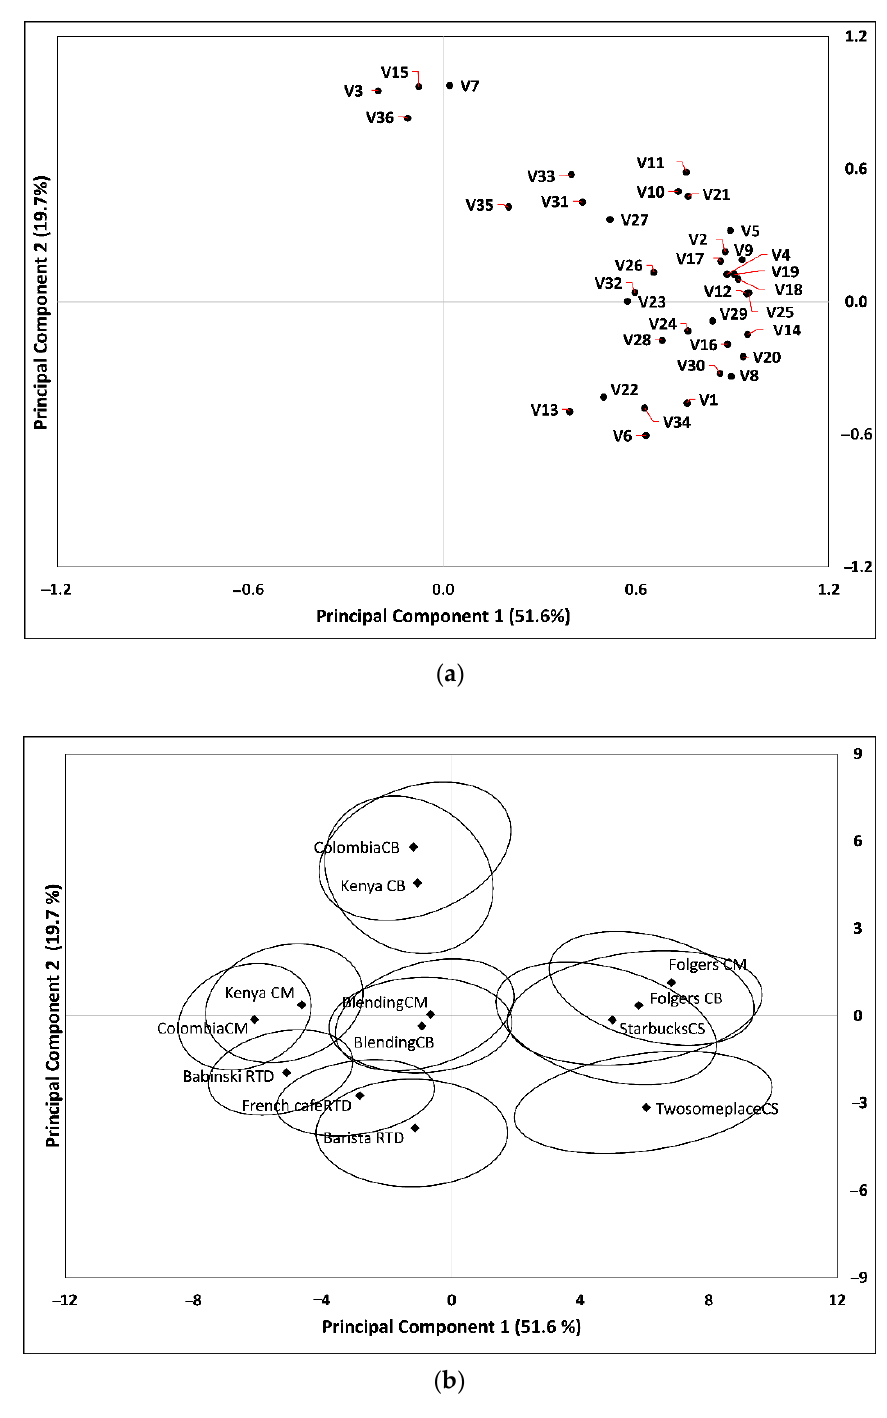
Figure 1. ( a ) Principal component analysis (PCA) of coffee samples and volatile compounds and ( b ) confidence ellipses map of the samples. V1–V36 stands for each volatile compound numbering in Table 4.